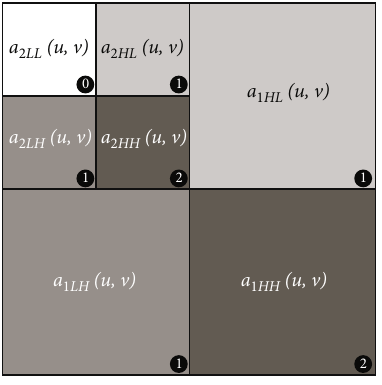
Figure 4: The image is divided into